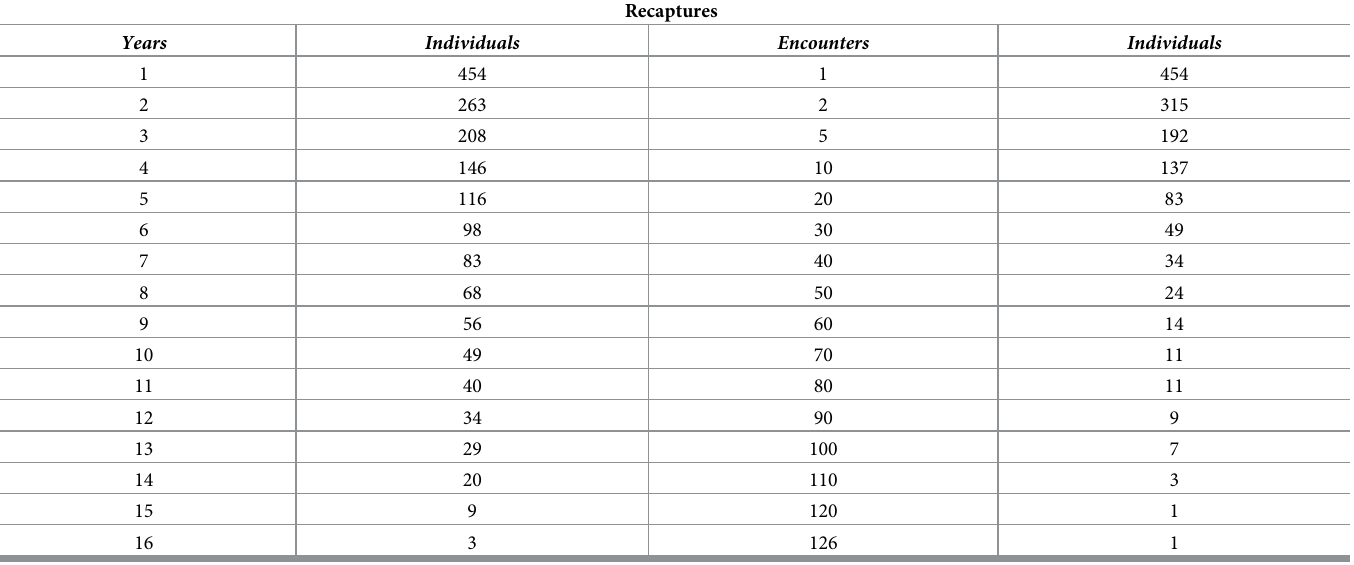
Table 2. Recapture statistics for identified humpback whales in our study.